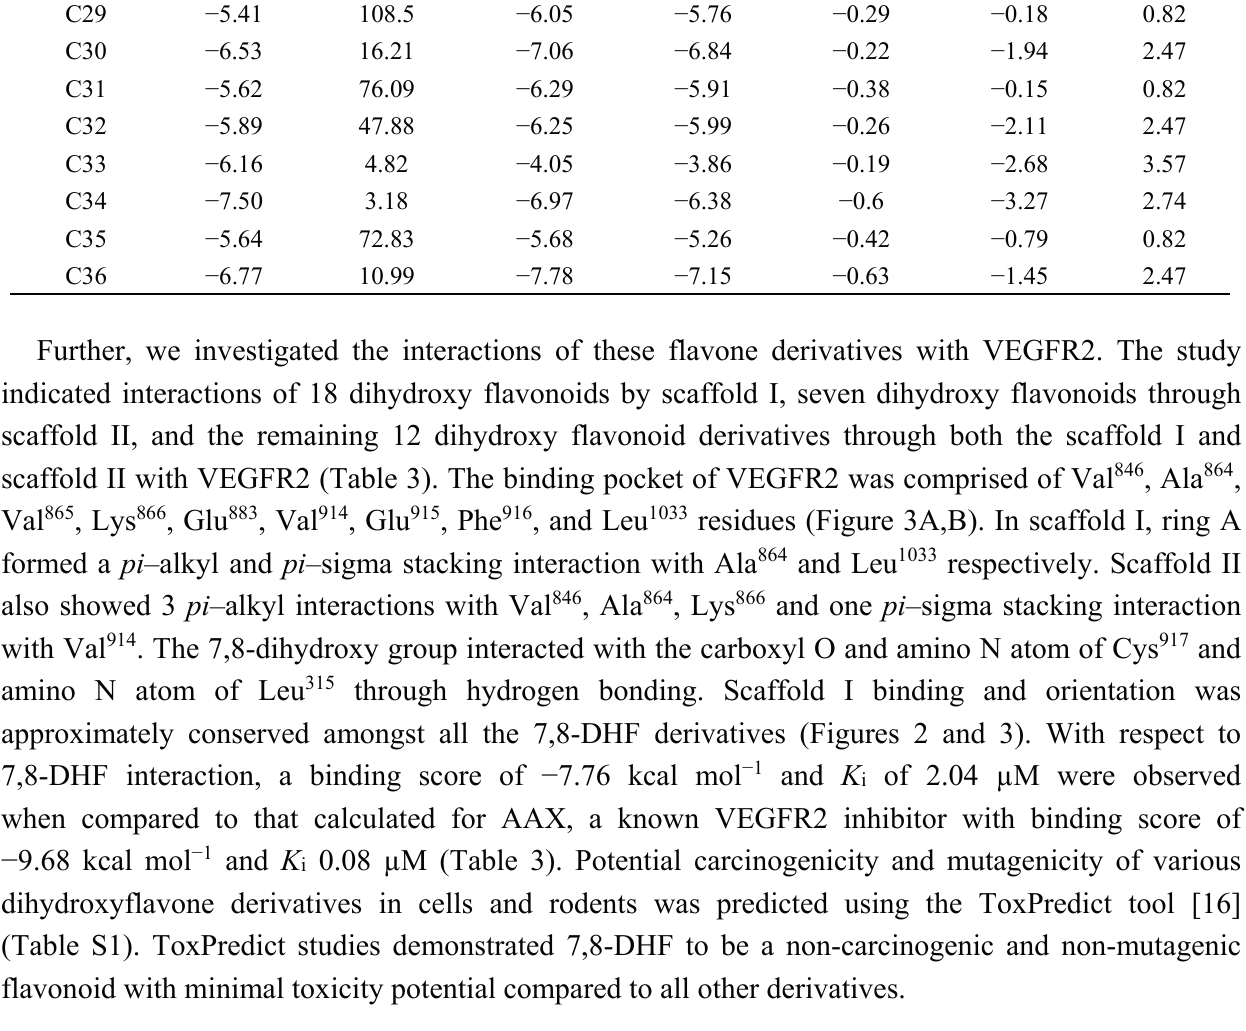
Table 3. 7,8-DHF and 36 di-hydroxy flavonoid derivatives with corresponding energies obtained from redocking validation followed by docking with VEGFR2 protein